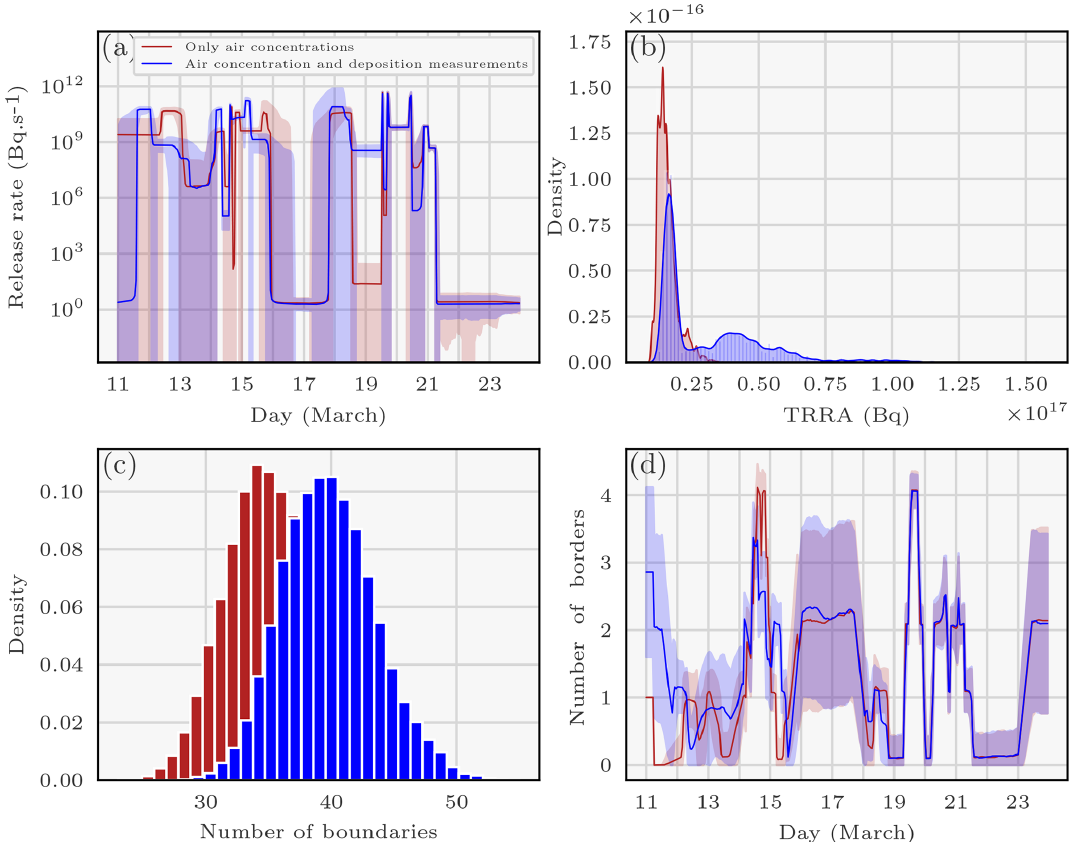
Figure 5. The panels correspond to probability densities or averages of variables describing the 137 Cs source reconstructed with the RJ-MCMC technique using air concentration and deposition measurements. Panel (a) displays the medians and standard deviations of hourly release rates. The red and blue curves correspond to the sampled median release rates. The red and light blue areas correspond to the areas between µ ln q , the median, and σ ln q , the standard deviation, of the sampled hourly release rates for each reconstruction: (cid:2) µ (cid:3) . Panel (b) shows the probability density of the total release of 137 Cs during the Fukushima Daiichi accident − σ + σ ln q ln q ,µ ln q ln q (in Bq). Panel (c) provides a histogram of the number of boundaries. Panel (d) shows the mean ( ± standard deviation) of the number of boundaries according to the hour